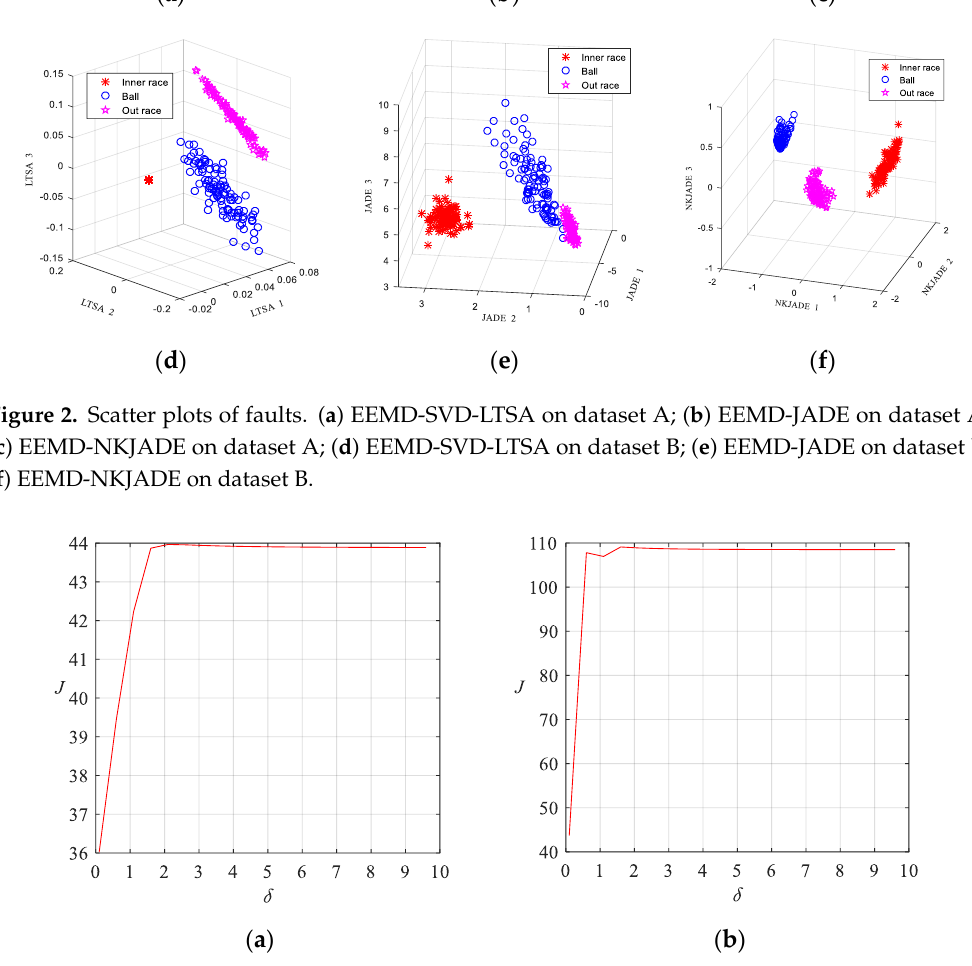
Figure 3. The results of selecting parameters for the Gaussian kernel. ( a ) Parameter selection results of Gaussian kernel of EEMD-NKJADE method on dataset A; ( b ) Parameter selection results of Gaussian kernel of EEMD-NKJADE method on dataset B.